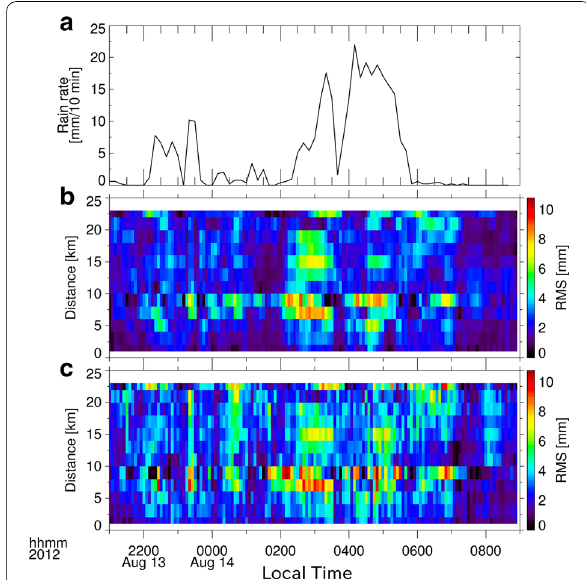
Fig. 3 a Time variation of 10-min rainfall observed by a rain gauge installed at RISH. b Time–distance variations of RMS of PWV CON around Uji. c Time–distance variations of RMS difference of PWV SPD–H around